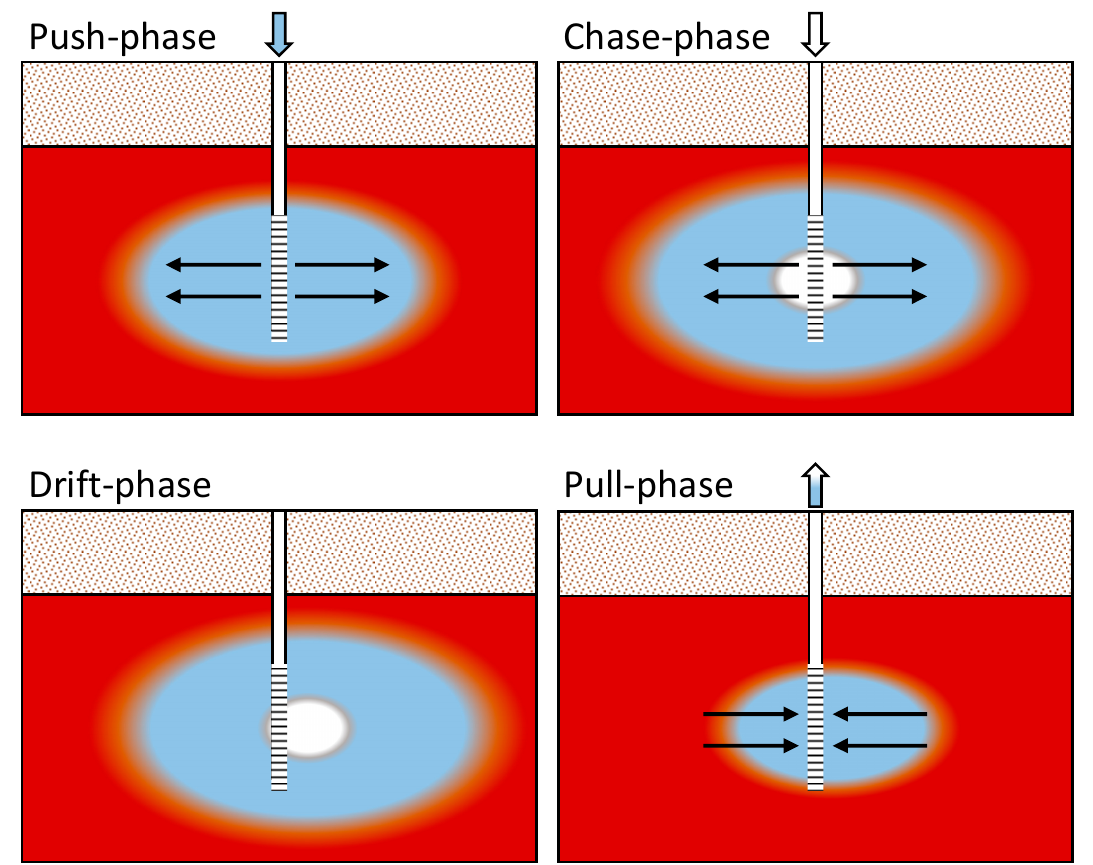
Figure 3. Conceptual diagram of the push–chase–drift–pull approach to the PPTs. Red indicates the contaminated aquifer, blue indicates the traced Gunnison River water, and white indicates the untraced Gunnison River water. The color variation between each main color represents dispersion. The arrows highlight the injection and pumping directions with the PPT well casing (solid white) and well screen (black horizontal lines) shown in the center of each diagram. This figure follows the formatting of Kruisdijk and van Breukelen [1]. Table 1. Push–Chase–Drift–Pull Testing Summary.